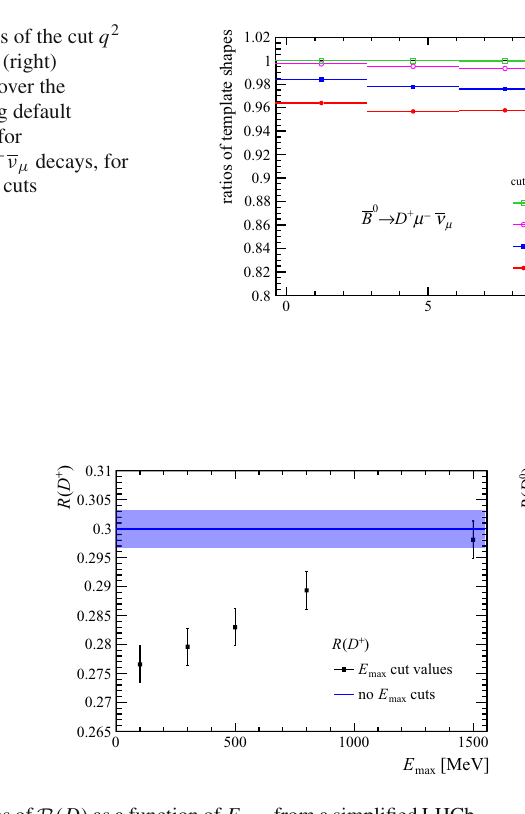
E max cuts are applied to the pseudo-experiments. The error bars reflect the statistical uncertainties from the generated MC samples. The blue bands correspond to fit results obtained with no E max